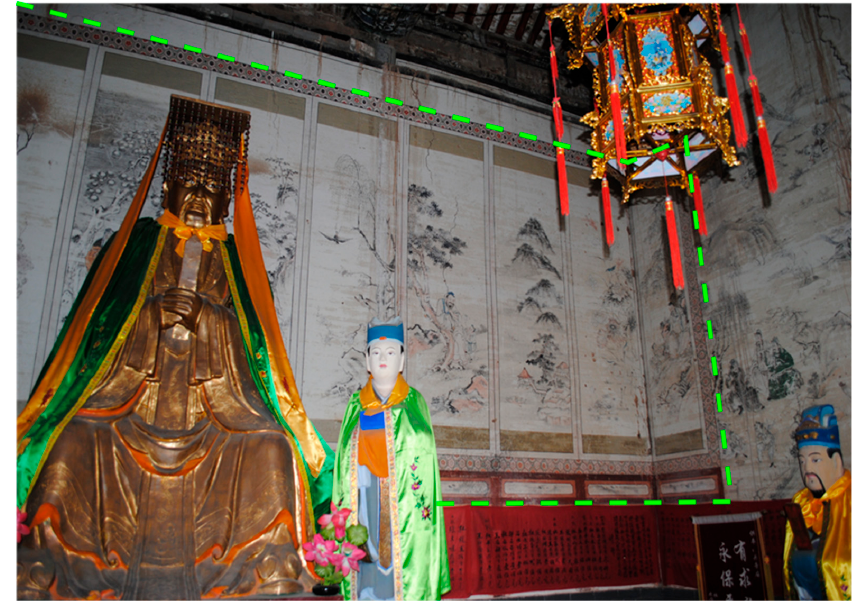
Figure 2. Part of 12 ‐ panel folding screen, within the green dashed lines, in the Guandi Temple in Ducun Village, Hexi Town (No. 64 in Figure 1).